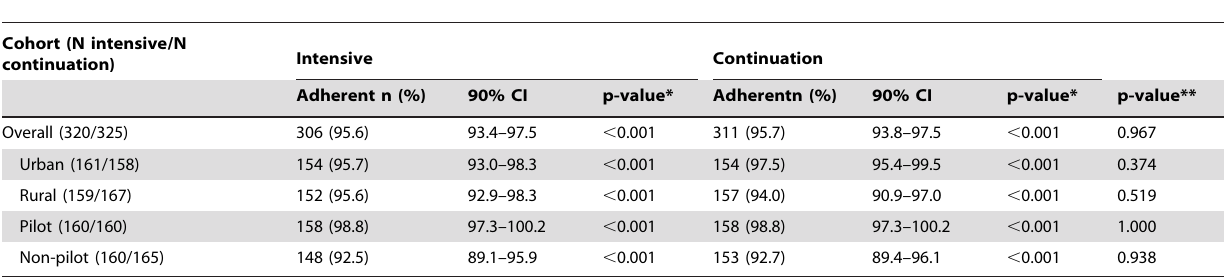
Table 2. Adherence to anti-TB drugs in intensive and continuation phase